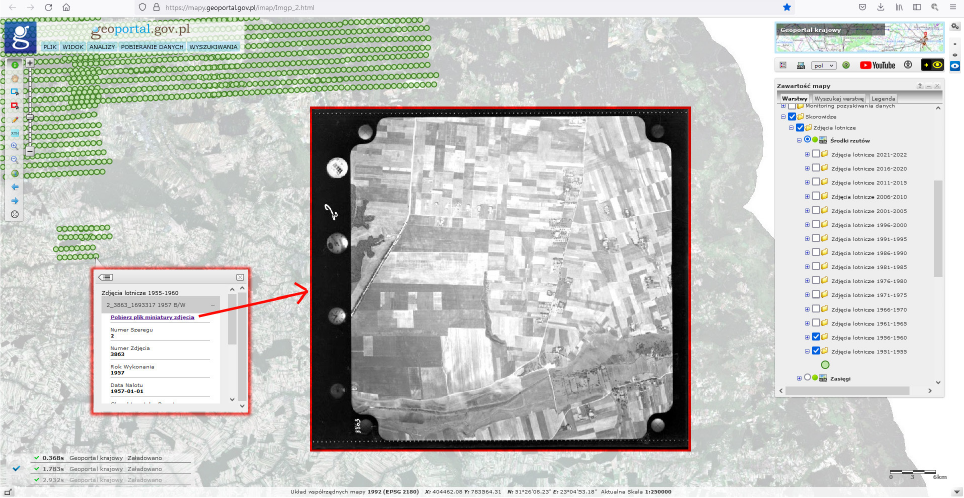
Fig. 11. Geoportal.gov.pl – index of archival aerial photographs from the 1950s with point distribution of projection centres, description of image metadata and downloadable thumbnail view. Own compilation based on